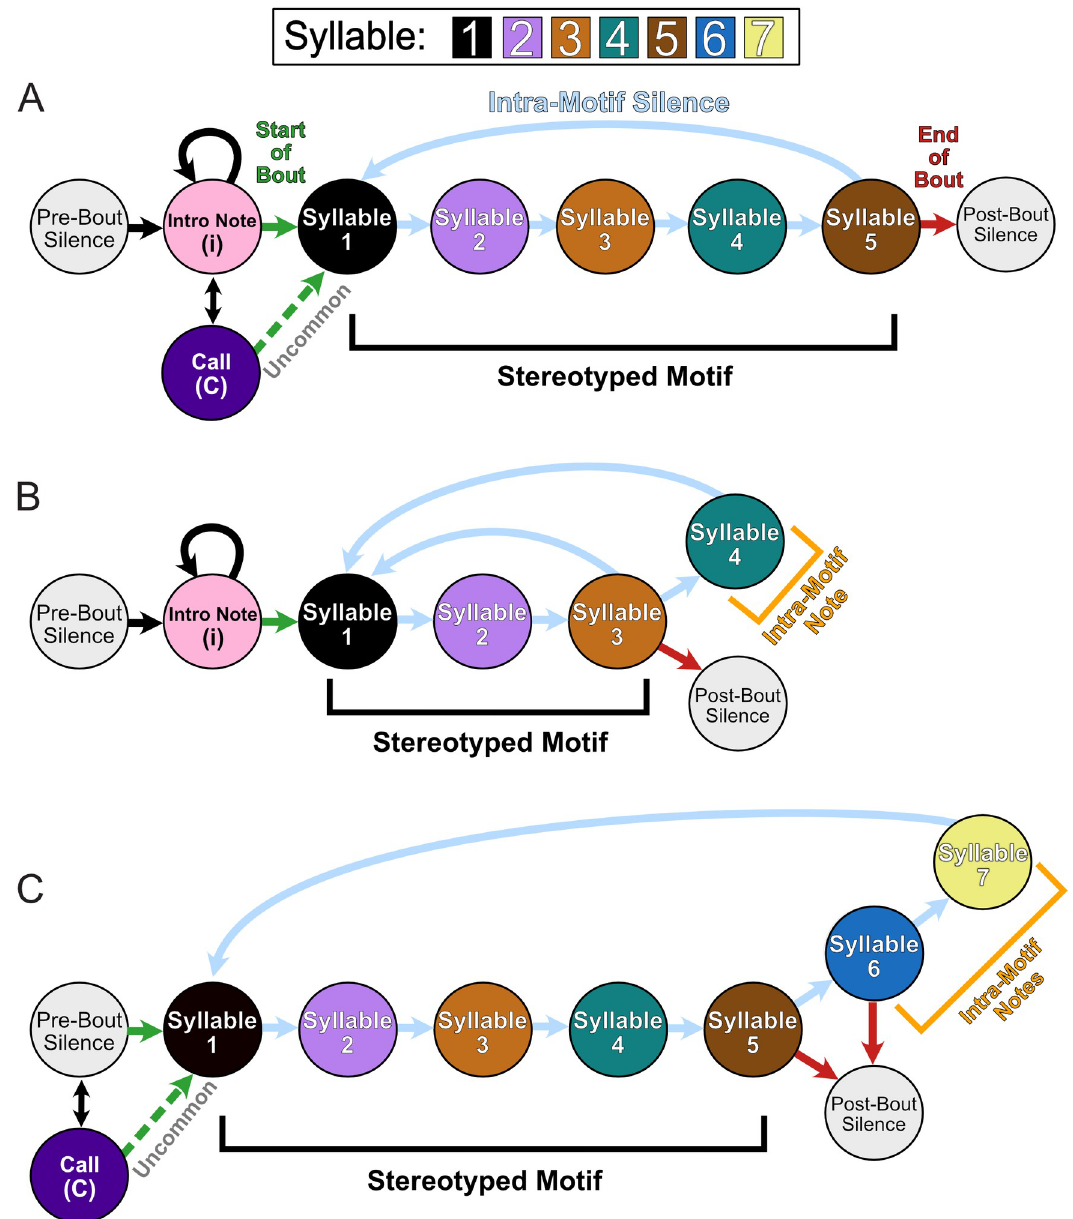
Fig 3. State Diagram of All Subjects Observed Song Behavior during High Yield Days. (A) Schematic showing the vocalization structure of subject z007’s song. (B) Schematic showing the vocalization structure of subject z020’s song, including its intra-motif note syllable 4. (C) Schematic showing the vocalization structure of subject z017’s song, including both of its intra-motif notes, syllable 6 and 7. For all three diagrams the green arrow represents the transition into the stereotyped motif song behavior; this sequence is underlined by a black bracket. The red arrow indicates the termination of the repeated motif sequence and the end of the bout.